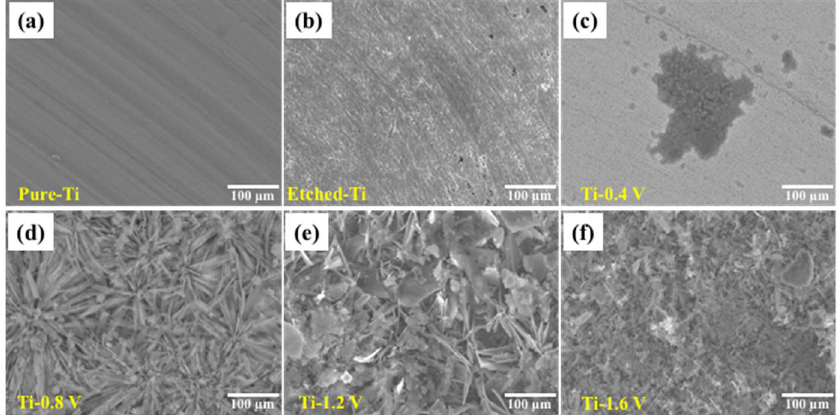
Figure 3. Scanning electron microscopy images of the HAp coatings after ECD on ( a ) pure Ti, ( b ) etched Ti, ( c ) Ti-0.4 V, ( d ) Ti-0.8 V, ( e ) Ti-1.2 V, and ( f ) Ti-1.6 V.